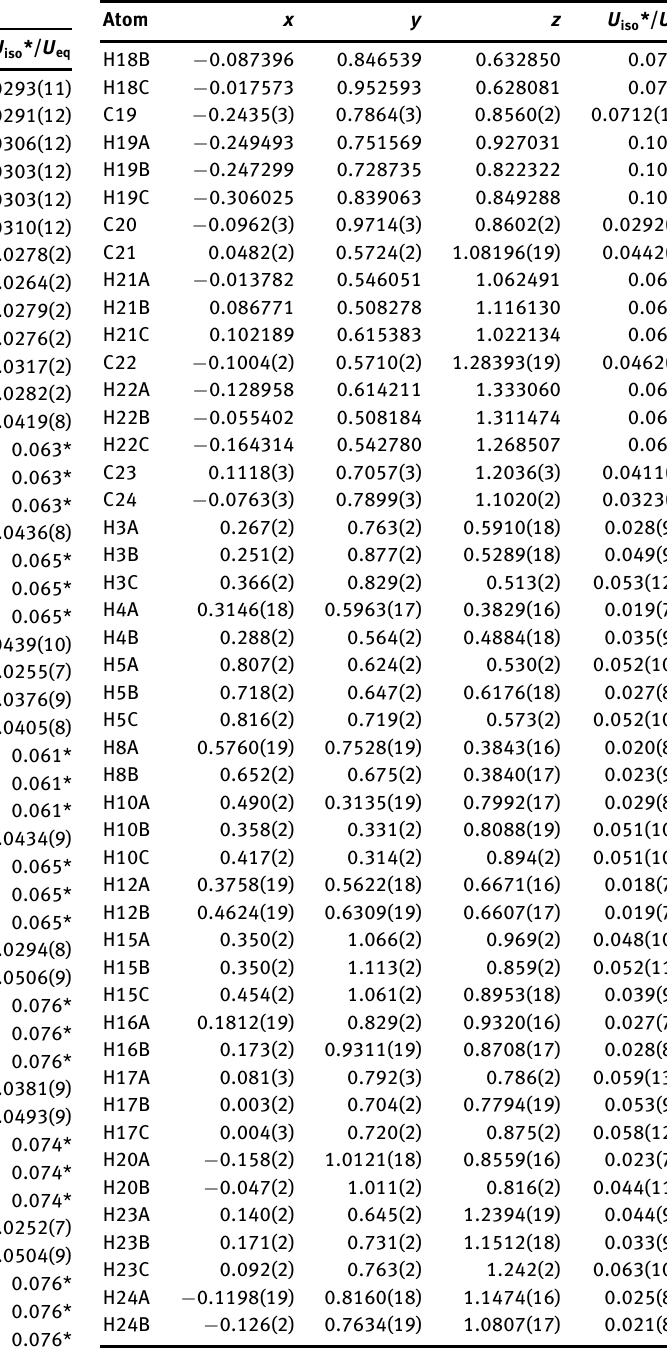
Table 2: Fractional atomic coordinates and isotropic or equivalent isotropic displacement parameters (Å 2